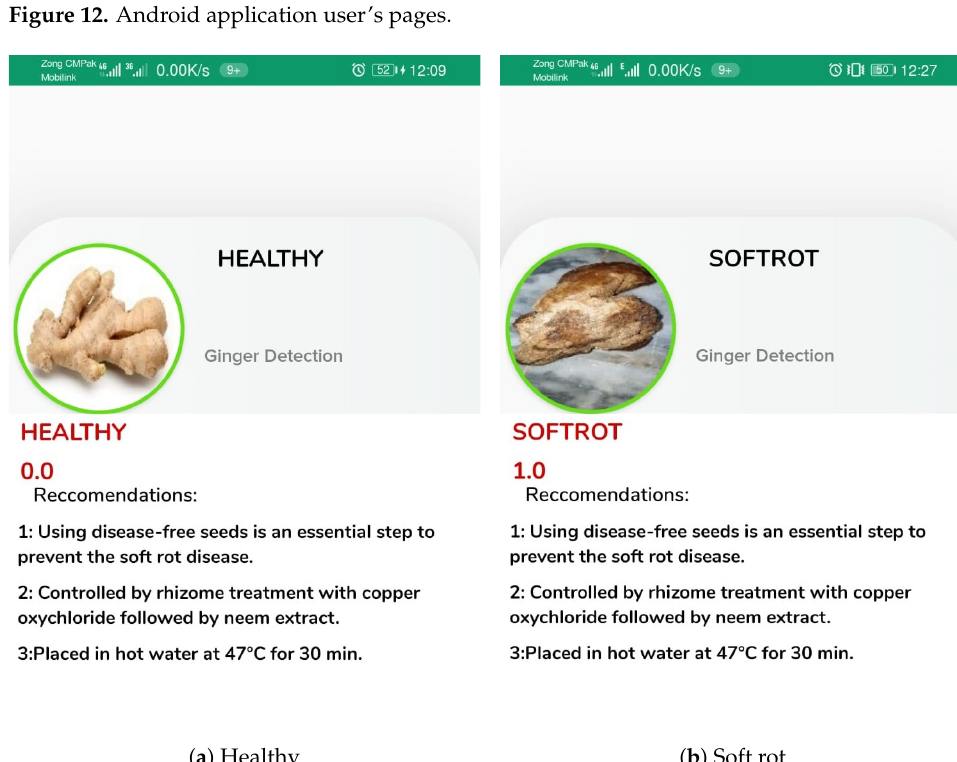
Figure 13. Example 1: Android application